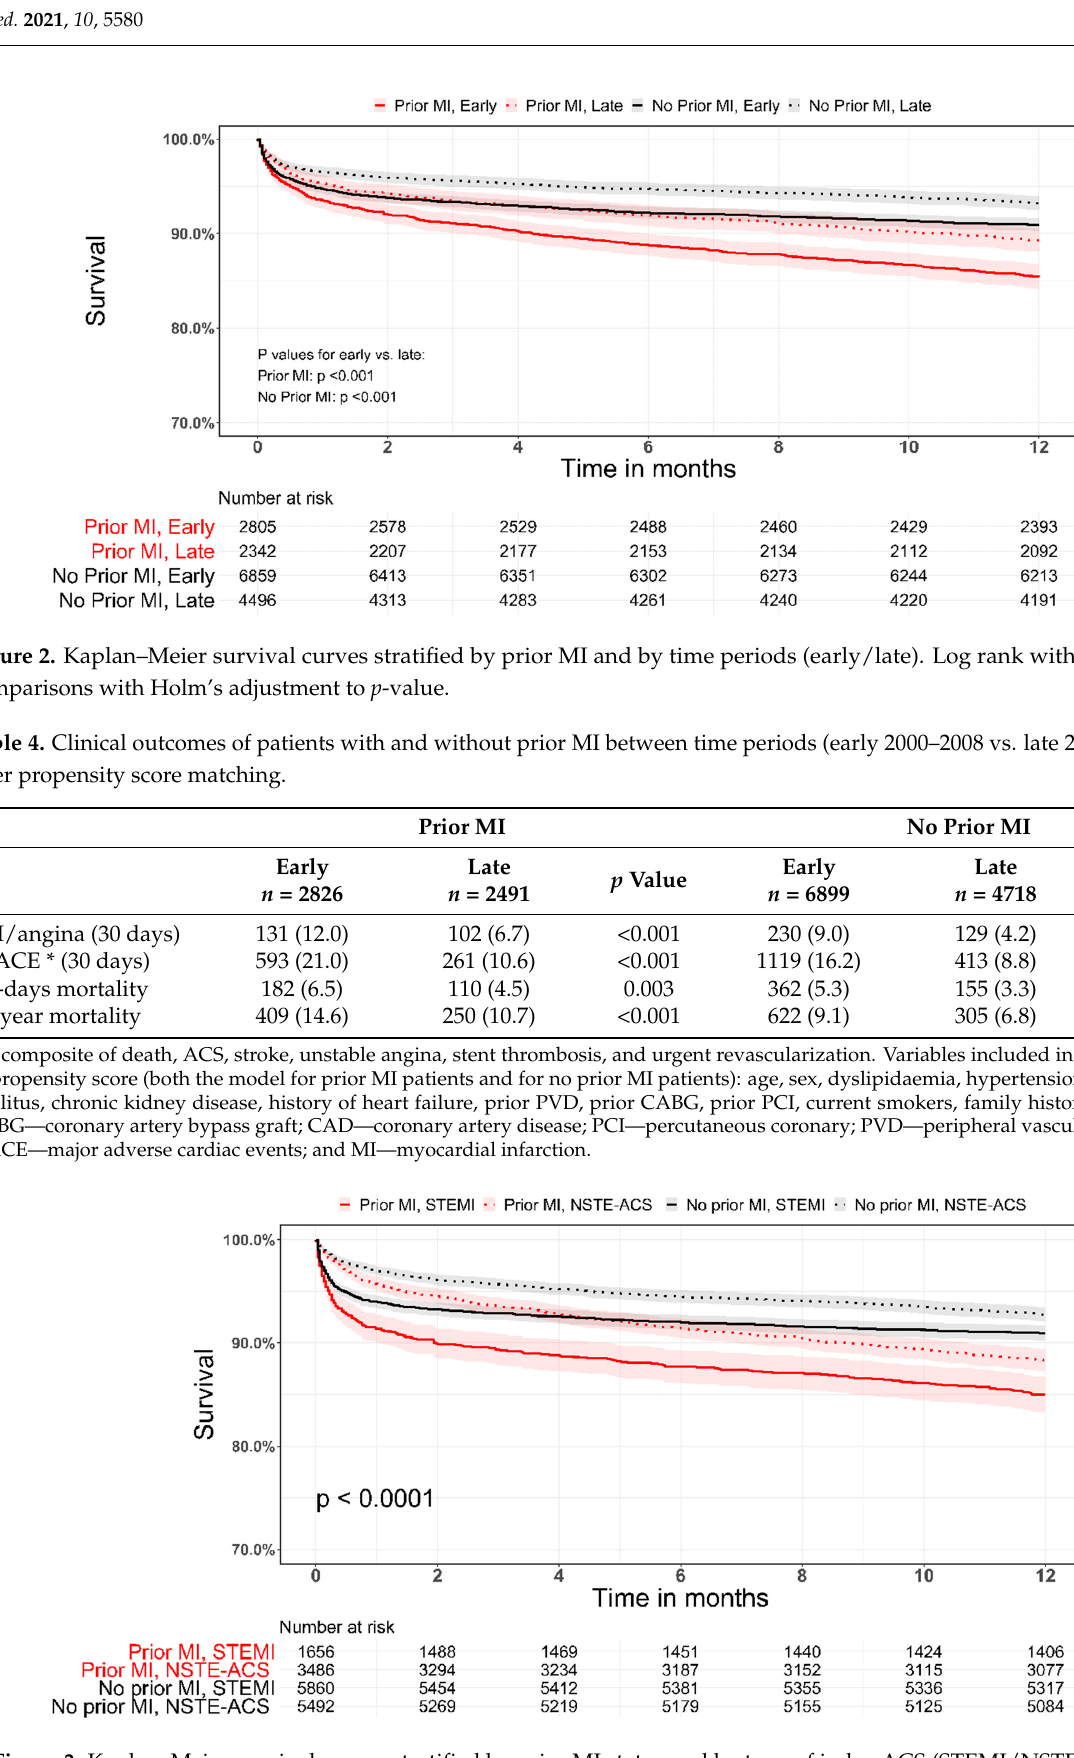
and baseline characteristics of the matched groups are presented in Supplementary Mate- rials Table S2 and Table 4. In the matched sample of patients with prior MI, the 30-day rates of re-MI/angina and MACE were significantly reduced in the late period (11.2% vs.